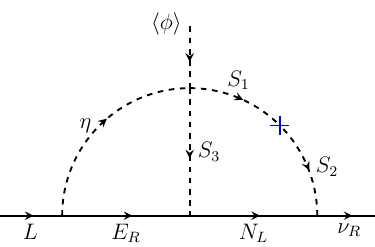
Figure 10 . Completely genuine two-loop diagram that gives mass to neutrinos. The blue cross marks the soft breaking term of the symmetry that allows the loop realization of the operator Z 2 L(cid:30) c (cid:23) R forbidding the